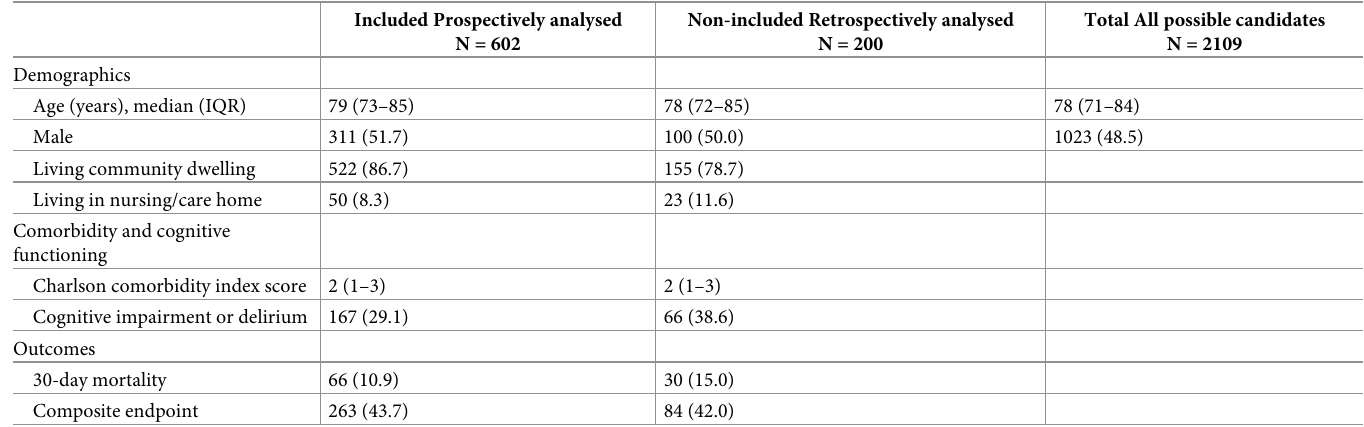
Table 6. Overview of characteristics and outcomes of included and non-included patients a